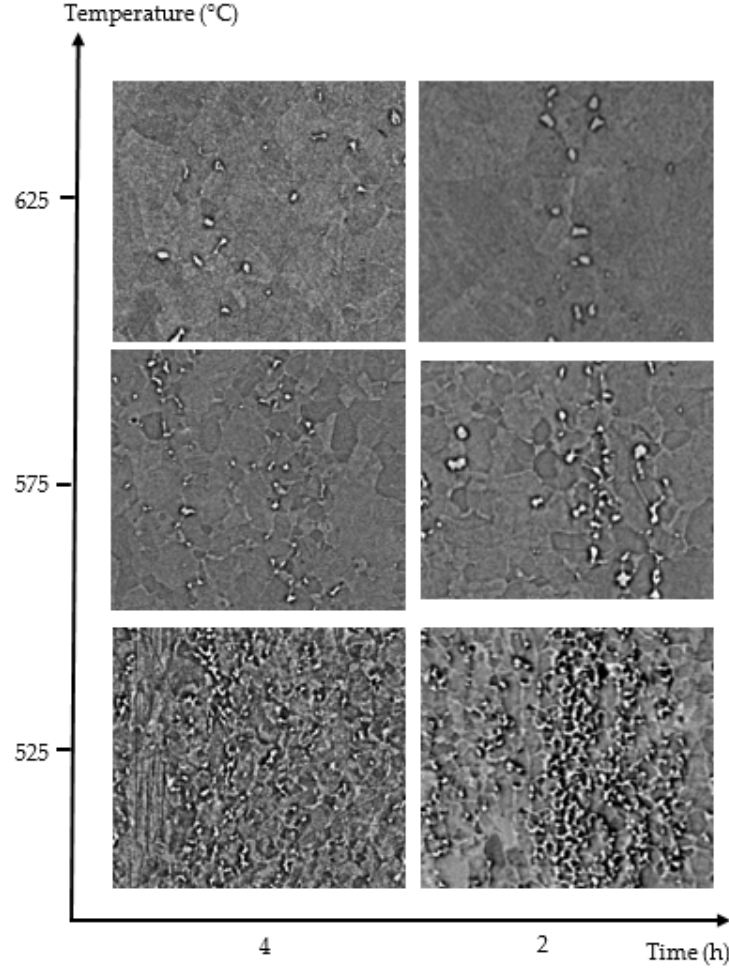
Figure 8. Microstructure evolution for 80% cold-rolled samples annealed at different temperatures and times.